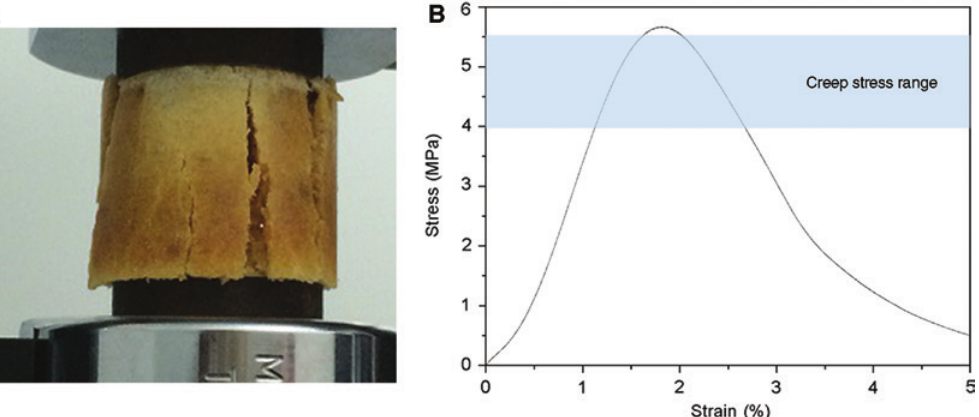
Figure 1: The process and result of monotonic compression test: (A) Appearance of the sample under monotonic compression and (B) the corresponding stress-strain curve of the studied